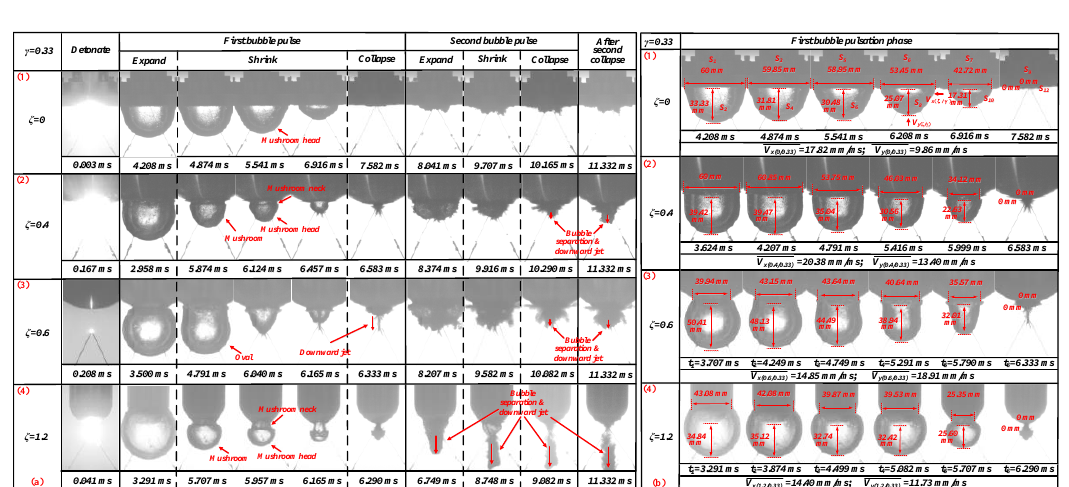
Figure 9. ( a ) The bubble’s morphological changes under the influence of di ff erent ζ values. The first row shows the bubble’s morphological changes when ζ = 0 and γ = 0.33. The second row shows the bubble’s morphological changes when ζ = 0.4 and γ = 0.33. The third row shows the bubble’s morphological changes when ζ = 0.6 and γ = 0.33. The fourth row shows the bubble’s morphological changes when ζ = 1.2 and γ = 0.33. ( b ) The bubble’s contraction speed under the influence of di ff erent ζ values. The first row shows the bubble’s contraction speed when ζ = 0 and γ = 0.33. The second row shows the bubble’s contraction speed when ζ = 0.4 and γ = 0.33. The third row shows the bubble’s contraction speed when ζ = 0.6 and γ = 0.33. The third row shows the bubble’s contraction speed when ζ = 1.2 and γ = 0.33.